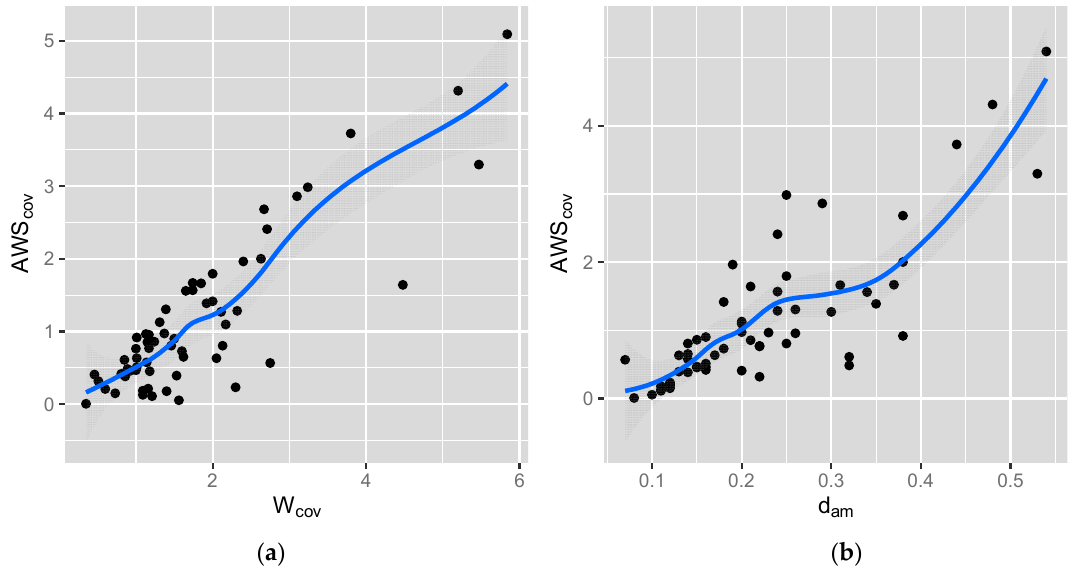
Figure 5. The closest correlation relationships for localities within the reference reaches between the value of the AWS Cov , and ( a ) fish cover width ( W Cov ) and ( b ) average maximum depth from all cross sections ( d am ).